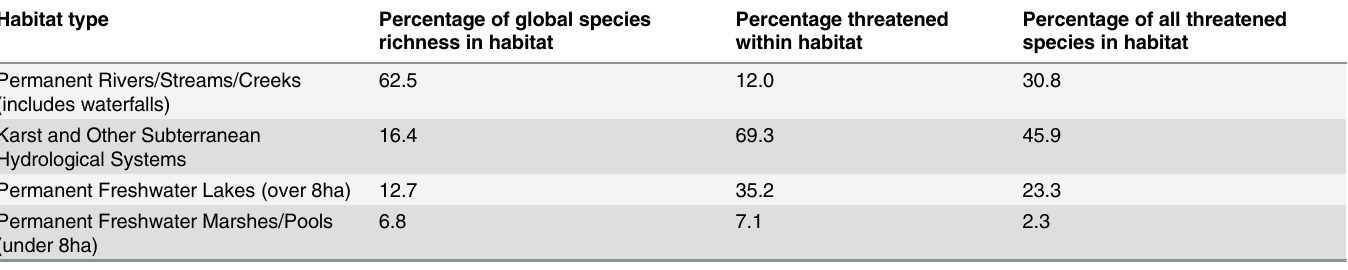
Table 2. Habitats containing over 5% of global species richness of freshwater shrimps (excluding Unknown Habitat) and their